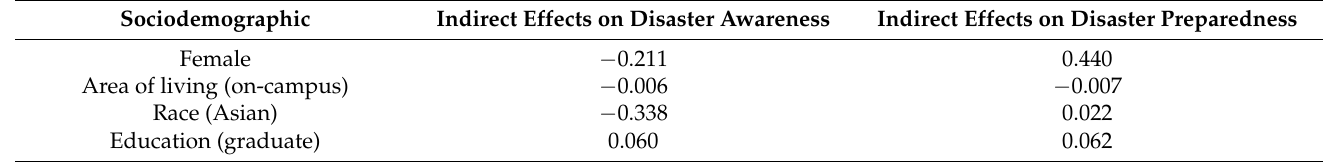
Table 6. Indirect effects on the output